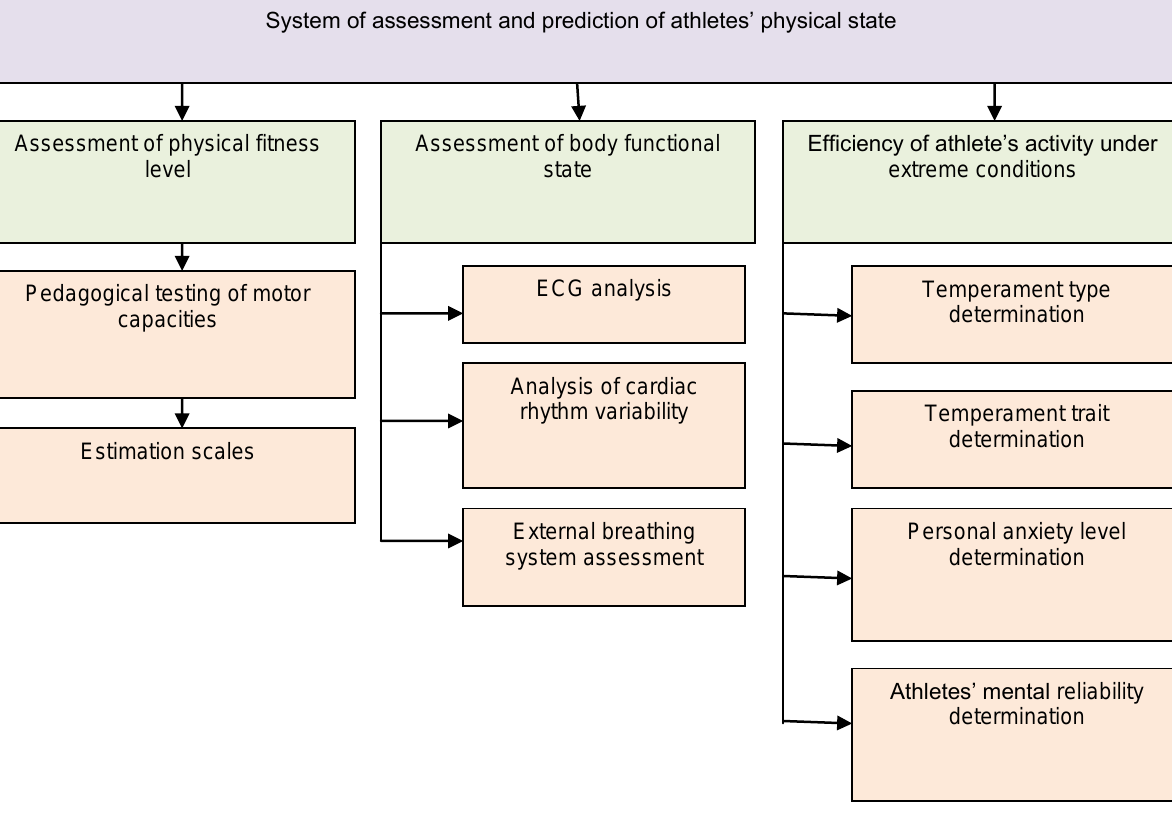
Fig. 5. Diagram of the system of assessment and prediction of physical state of skilled track and field athletes – members of reserve national team of